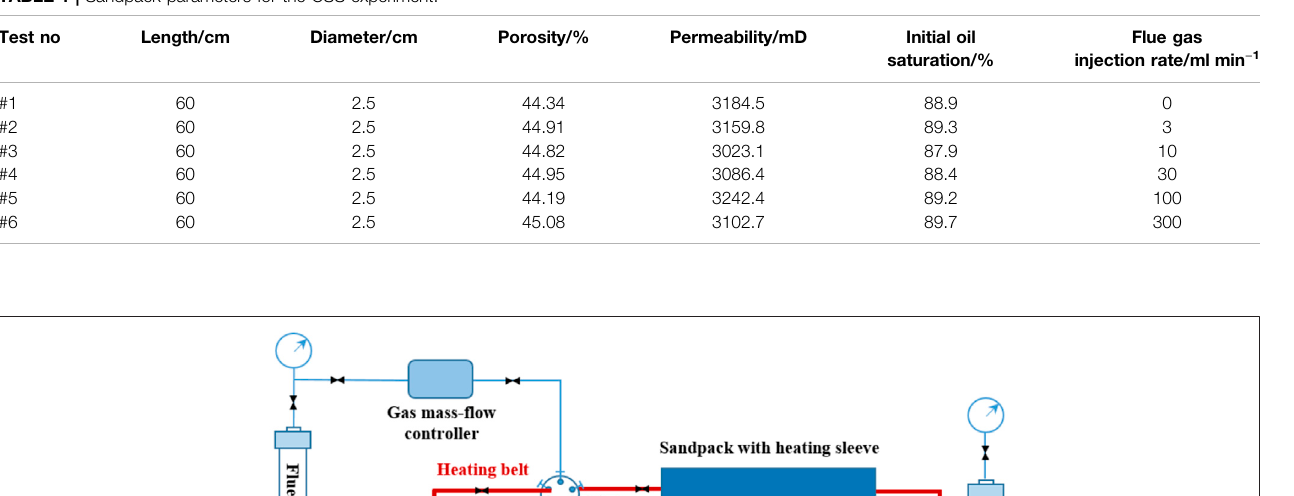
Frontiers in Energy Research |